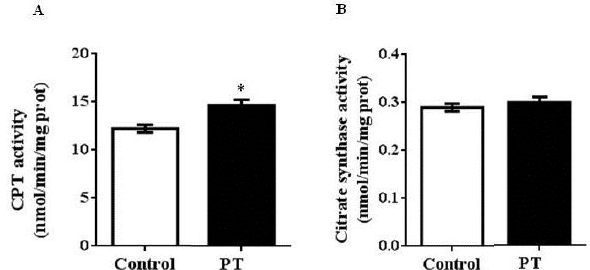
Figure 3. Carnitine palmitoyltransferase-1a (CPT-1a) ( A ) and citrate synthase (CS) ( B ) activities in liver from fa / fa Zucker rats either treated or not with pterostilbene (30 mg/kg body weight/day) for 6 weeks. Values are means ± standard error of the mean (SEM) ( n = 10). Differences between groups were determined by the Student’s t test. Statistical significance was set at the p < 0.05 level. * p < 0.05. With regard to MTP, a significant increase was observed in the PT group ( p = 0.001) (Figure 4).